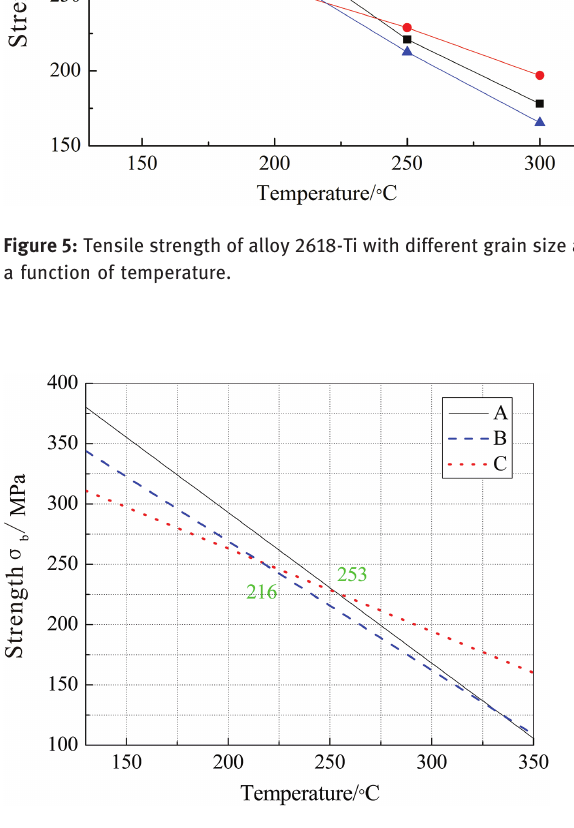
Figure 6: The linear fitting of the tensile strength of alloy 2618-Ti with different grain size as function of